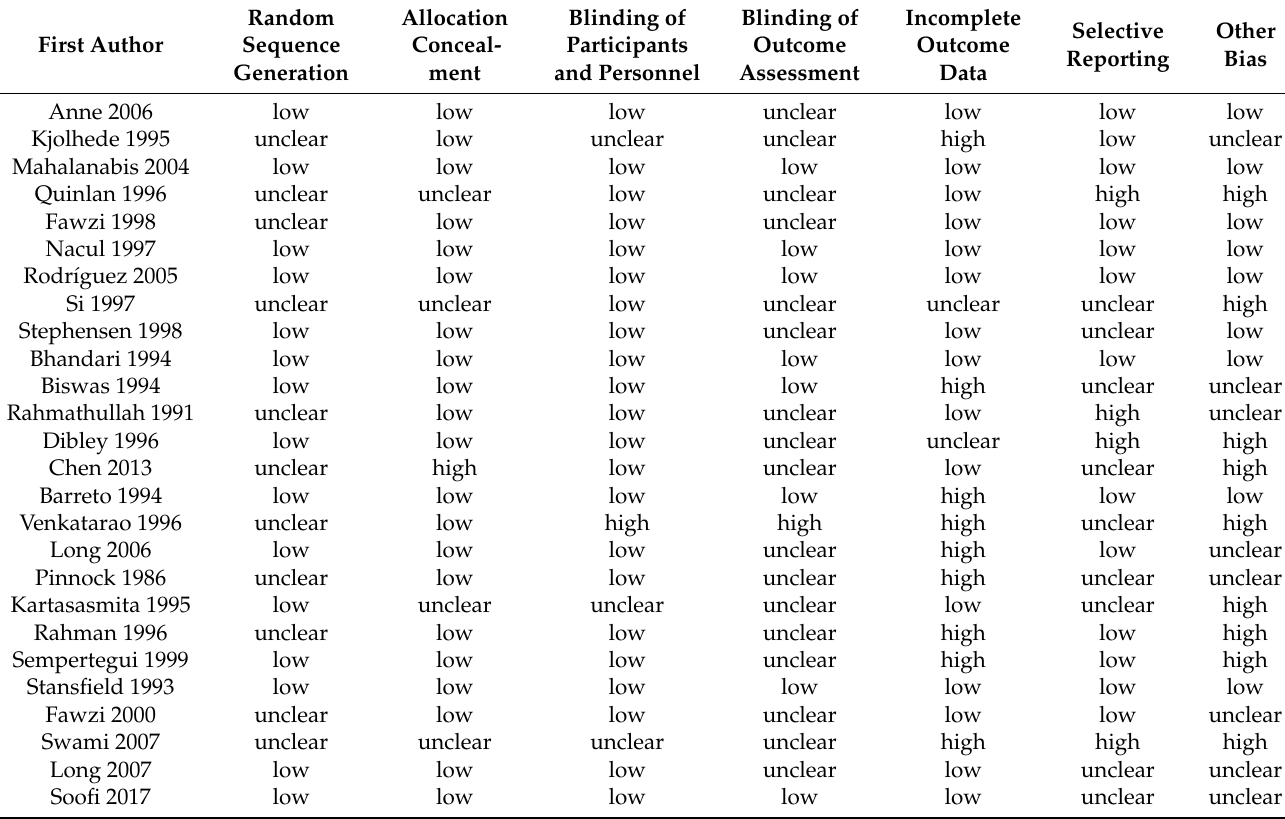
Table 2. Quality of the studies included in the